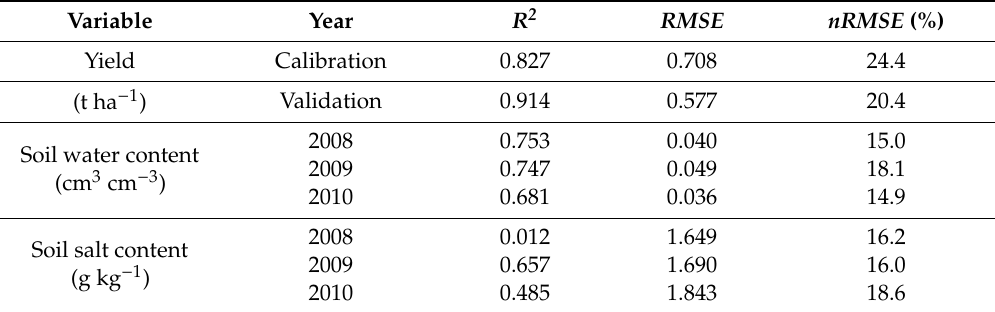
Table 2. Model prediction accuracy for yield ( Y ), soil water content ( θ ), and soil salt content ( S ). Variable Year R 2 RMSE nRMSE (%) Yield